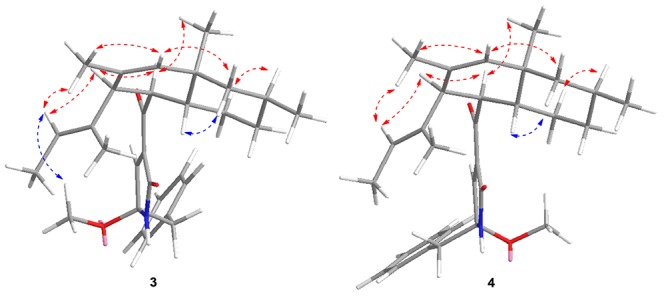
Key NOESY correlations of 3 and 4.